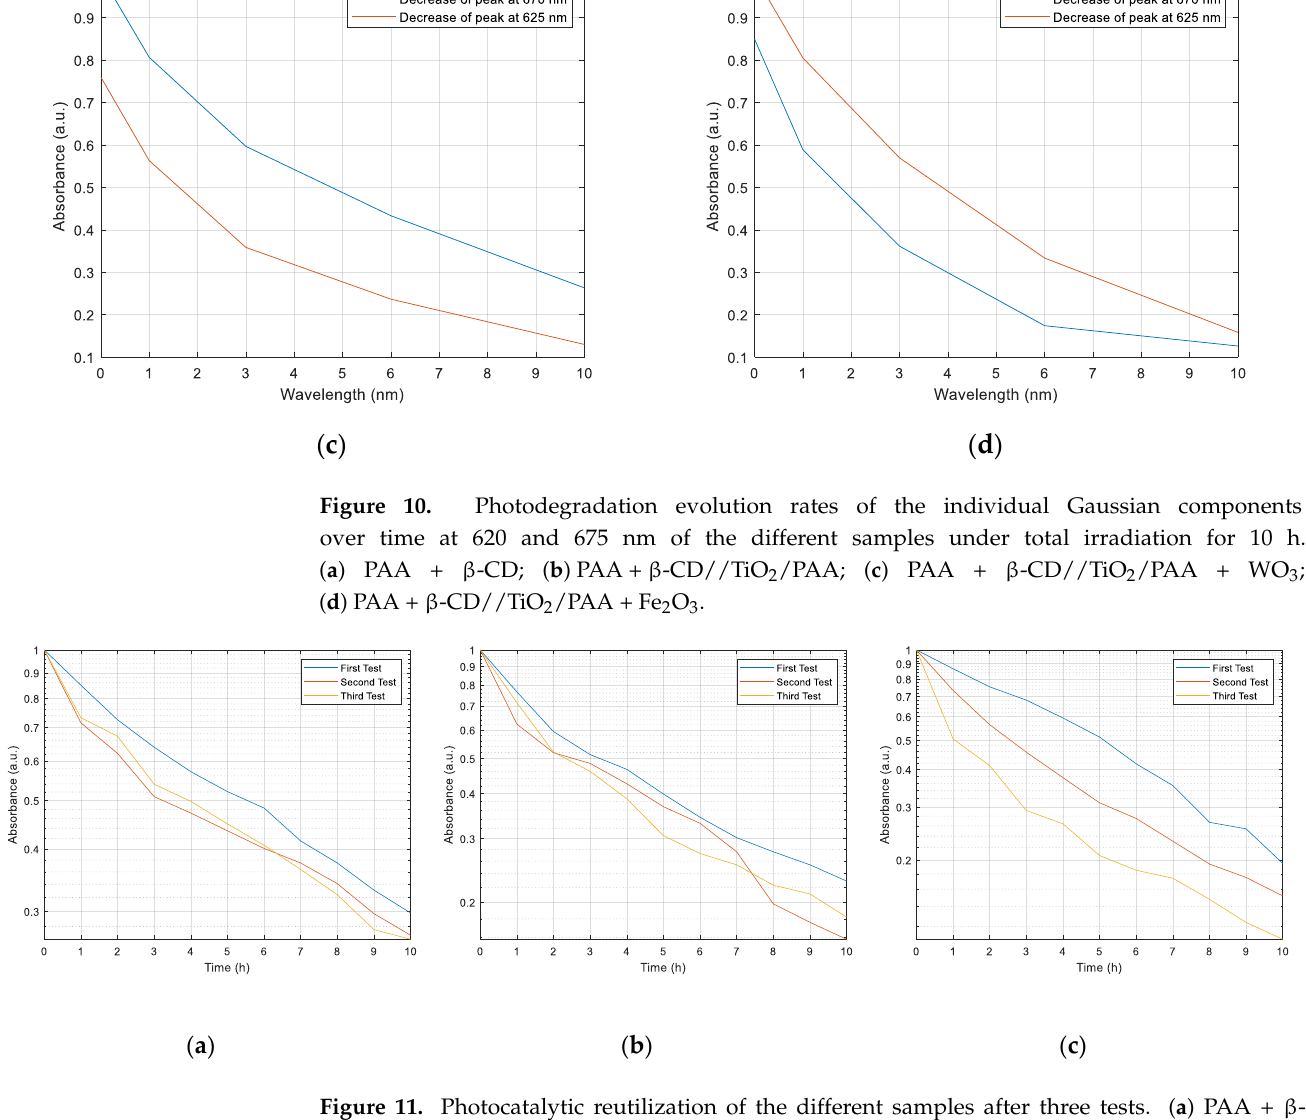
Figure 10. Photodegradation evolution rates of the individual Gaussian components over time at 620 and 675 nm of the different samples under total irradiation for 10 h. ( a ) PAA + β -CD; ( b ) PAA + β -CD//TiO 2 /PAA; ( c ) PAA + β -CD//TiO 2 /PAA + WO 3 ; ( d ) PAA + β -CD//TiO 2 /PAA + Fe 2 O 3 .